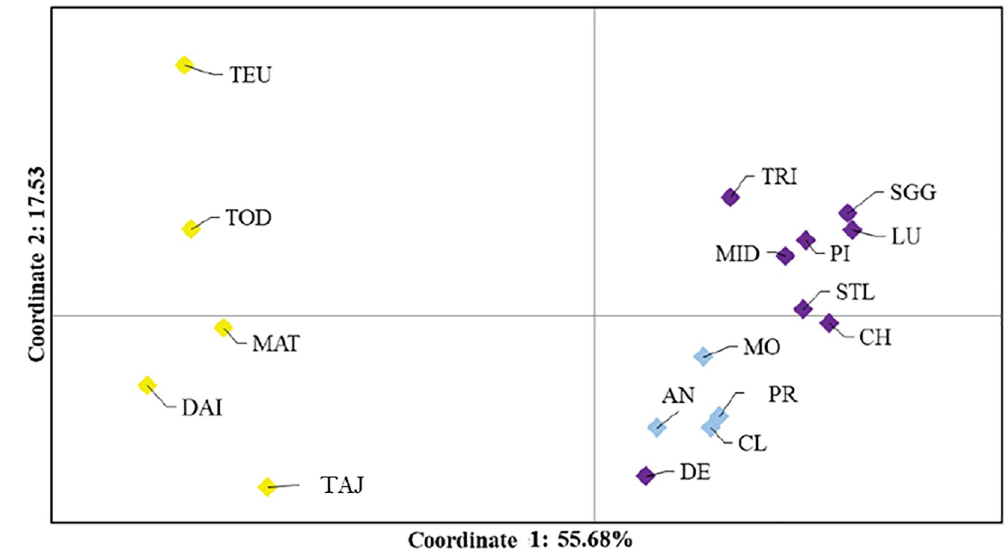
Fig 4. PCoA analysis conducted in GenAlEx v6.5 based on pairwise F ꞌ ST values for the western and eastern North Pacific rhinoceros auklet breeding colonies. Coordinates 1 and 2 explain 55.7% and 17.5% of the variation (not shown: coordinate 3 at 8.4%). The colours correspond to the three groups detected using STRUCTURE (Figs 2 and 3): western Pacific (yellow), the larger eastern Pacific group (purple) and smaller eastern Pacific group (blue).